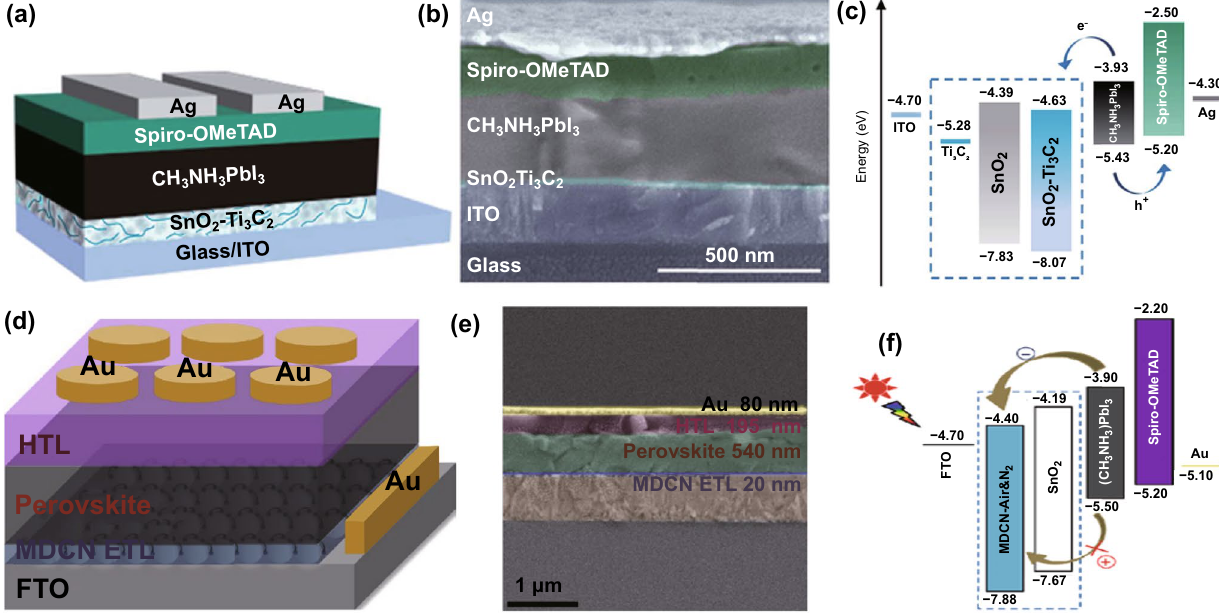
Fig. 3 a Device architecture, b cross-sectional SEM image and c schematic energy-level diagram of each component for the PV device of ITO/ Ti 3 C 2 T x MXene-added SnO 2 ETL/MAPbI 3 /Spiro-OMeTAD/Ag. Copyright © 2019 The Royal Society of Chemistry. d Device architecture, e cross-sectional SEM image and f schematic energy-level diagram of each component for the PSCs using MDCN as the